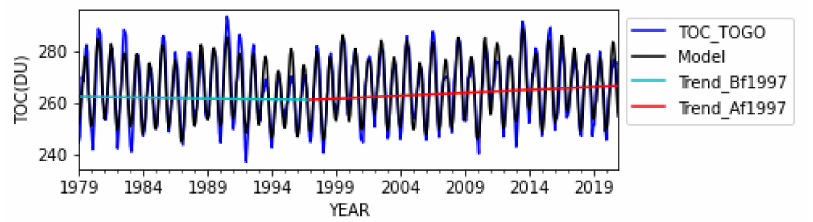
Figure 5. Evolution of the monthly average ozone over Togo observed by MSR-2, simulated by the MLR model, and the trends estimated by the model before and after